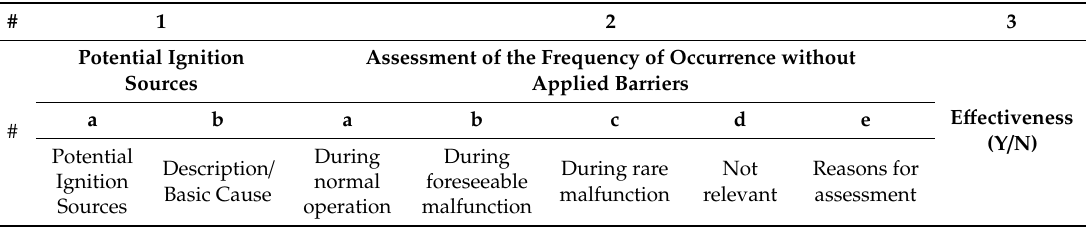
Table 7. Scheme for the identification and assessment of ignition